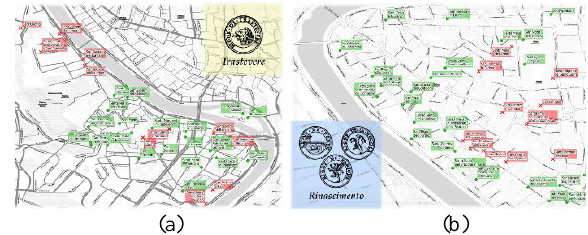
Figure 6. Map of a district. Surveyed churches in green. (a) District of Trastevere. (b) District of Rinascimento.